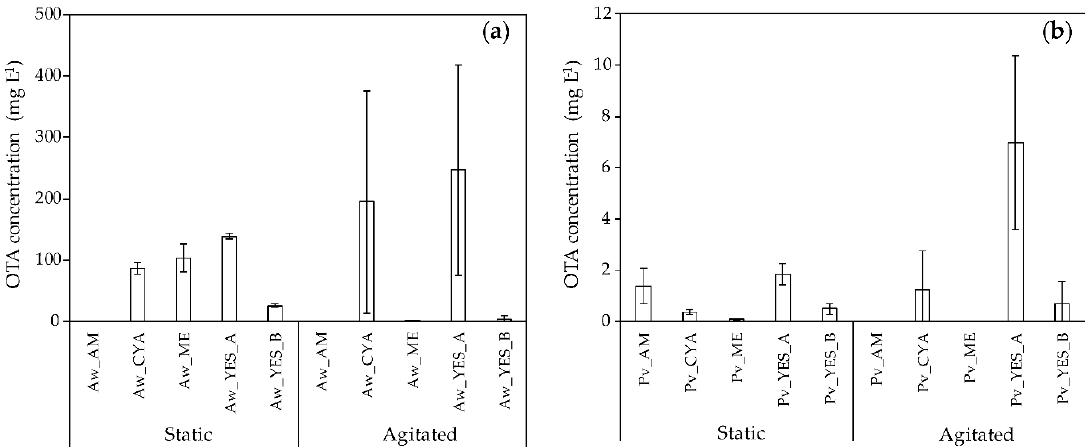
Figure 1. Ochratoxin A (OTA) production in Adye and Mateles (AM), Czapek Yeast Autolysate (CYA), Malt Extract (ME), Yeast Extract Sucrose_A (YES_A), and YES_B media by ( a ) Aspergillus westerdijkiae (Aw) and ( b ) Penicillium verrucosum (Pv) under static and agitated conditions. Data are means ± standard deviation using three biological replicates.